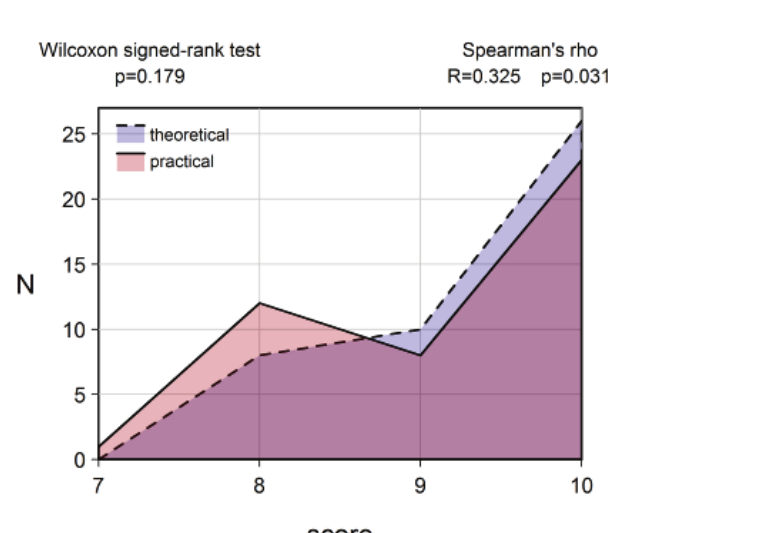
Figure 3 – Outcomes of assessing the ”radio operation” assignment Рис . 3 – Результаты оценивания задачи « организация радиосвязи » Слика 3 – Резултати оцењивања задатка " комуникација путем радија